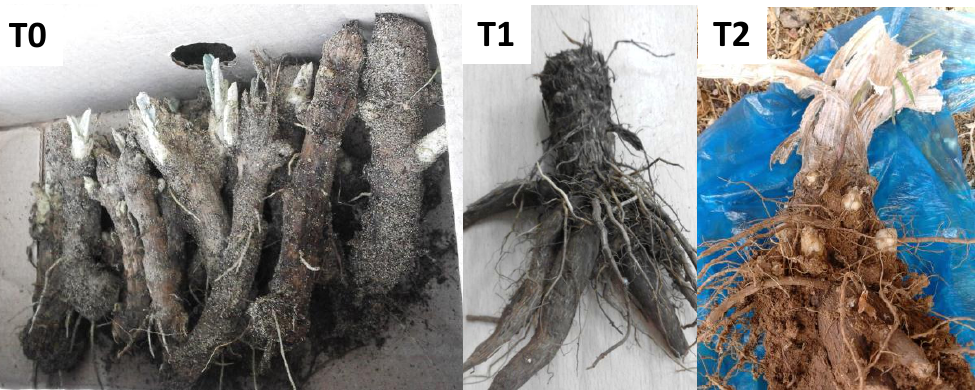
Figure 7. Cutting management considered in the experiment: summer field’s ovoli (T0), spring offshoots nursery’s cuttings forced to pass a vegetative rest period by stopping irrigation (T1), and offshoots nursery’s cuttings not forced (T2).